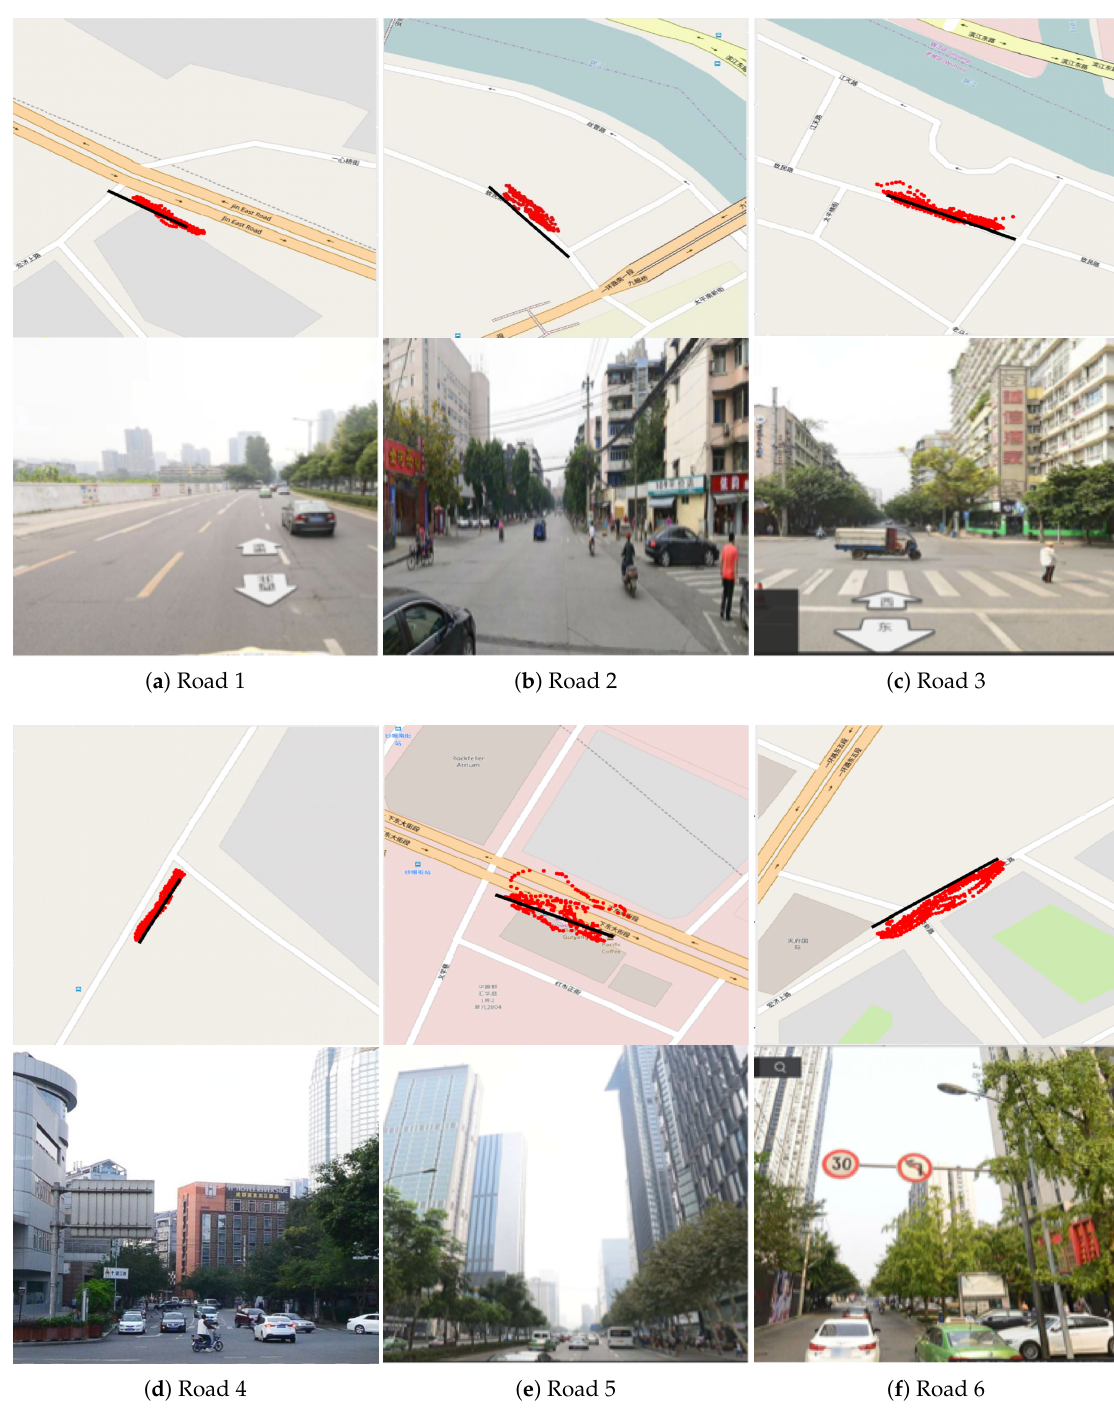
Figure 5. Field testing results and street views of road